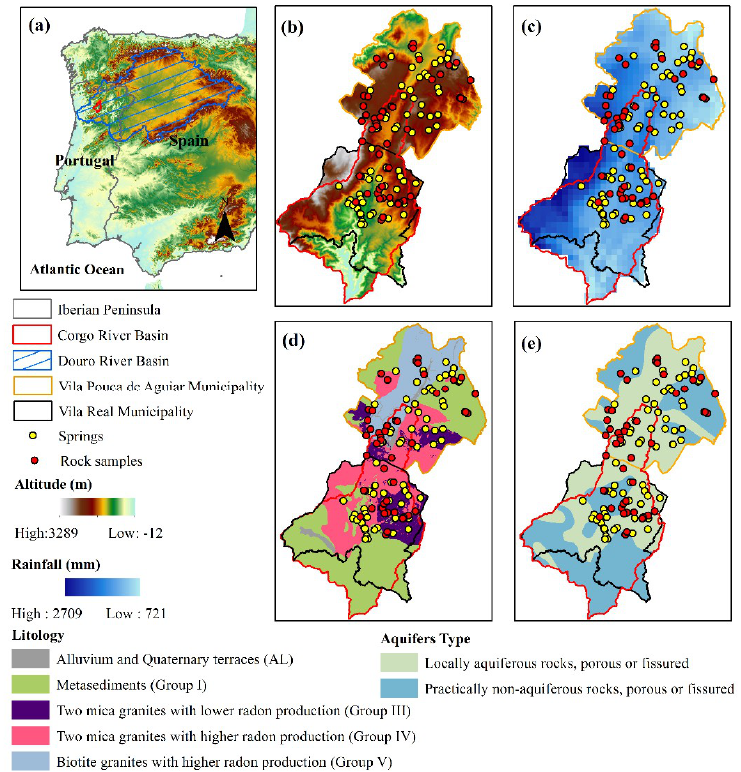
Figure 1. Several hydrogeological, topography, precipitation, and geology networks represented for the studied region: ( a ) Topography of Iberian Peninsula; ( b ) digital elevation/drainage network models of studied region; ( c ) distribution of mean annual precipitation in millimeters between 1960 and 1991, [6]; ( d ) simplified geological map of studied area, based on the Geological map of Portugal, scale 1:500,000 and 1:50,000 in the influence areas of the geological maps 10B (Vila Real) and 6D (Vila Pouca de Aguiar) [33]; and (e) aquifers type,